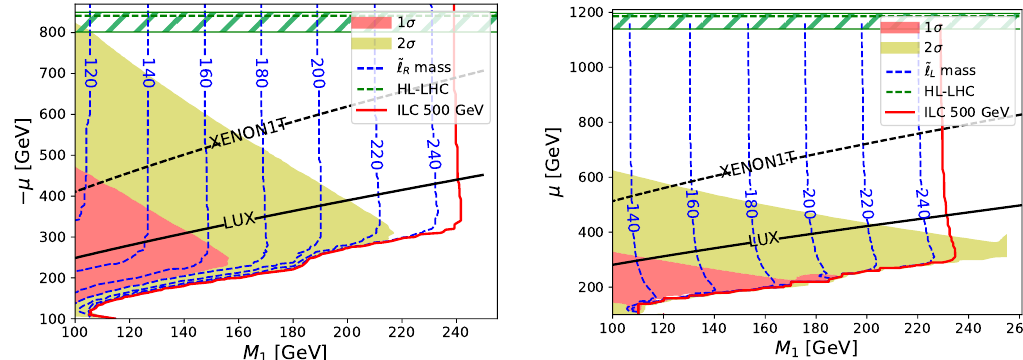
Figure 1 . The parameter region of our interest for the BHR scenario (left panel) and BHL scenario (right panel), together with experimental constraints and future prospects. We use tan (cid:12) = 40 and M 2 = 3 TeV. The blue contours show the slepton mass m ~ or m ~ that gives (cid:10) LSP = (cid:10) DM . With ‘ R ‘ L the slepton mass, the muon g (cid:0) 2 discrepancy is explained within 1 (cid:27) (2 (cid:27) ) uncertainty in the red (yellow) regions. The regions below the solid (dashed) lines are excluded (will be probed) by the LUX (XENON1T) experiment with 90% con(cid:12)dence level. The regions below the green dashed lines p will be probed by the HL-LHC with s = 14 TeV and R L = 3000 fb (cid:0) 1 , assuming 30% systematic uncertainty from SM background; the green hatched regions correspond to di(cid:11)erent systematic uncertainties between 20% and 50%. The red solid line corresponds to m ~ = 248 GeV, which will ‘ p be probed at the ILC with s = 500